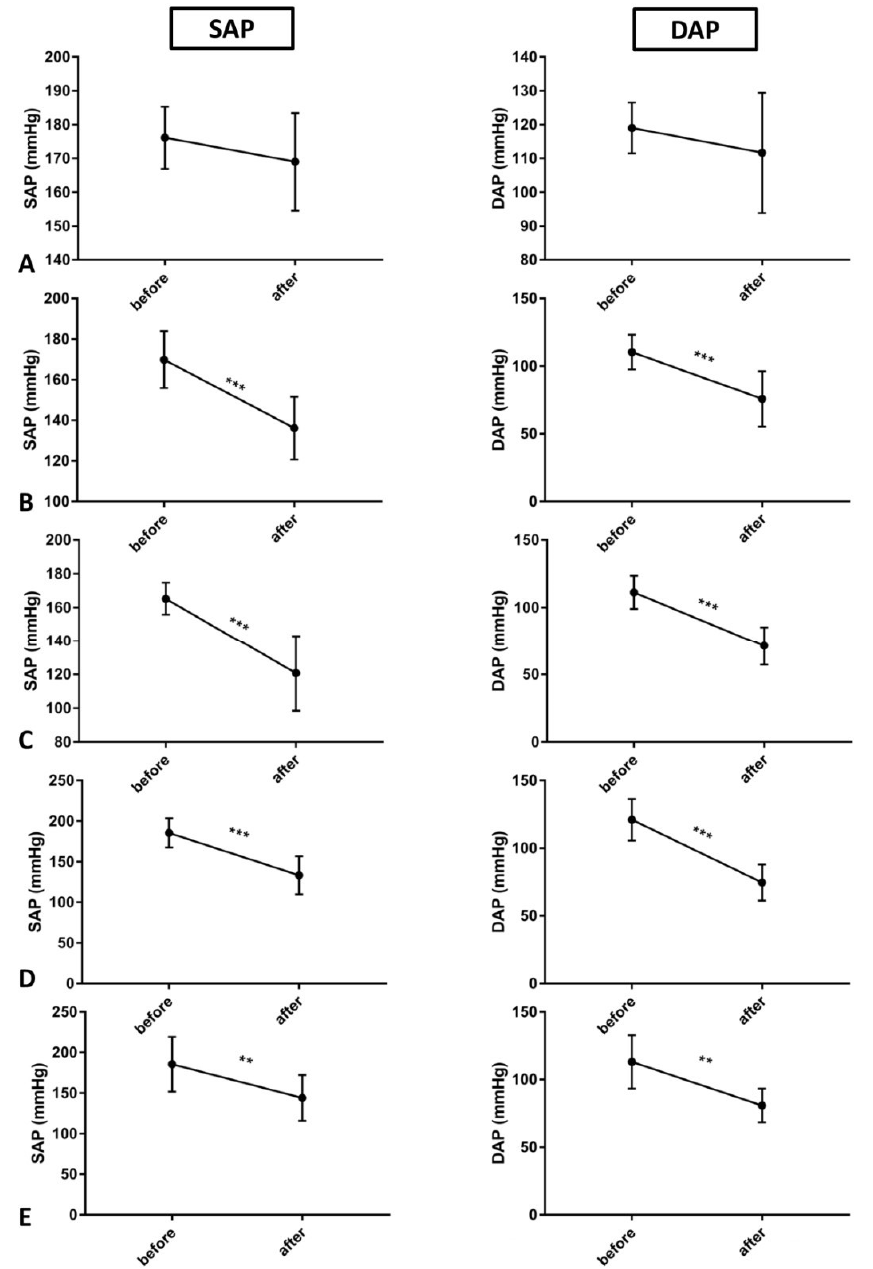
Figure 3. SAP and DAP values before and after surgical procedures in each experimental groups: SHAM ( A ), AKI ( B ), AKI + APO ( C ), AKI + HBO ( D ), AKI + APO + HBO ( E ); SAP—systolic arterial pressure, DAP—diastolic arterial pressure; SHAM—sham-operated rats; AKI—rats with induced postischemic acute kidney injury; AKI + APO—animals with acute kidney injury and apocynin treatment; AKI + HBO—group exposed to HBO preconditioning before acute kidney injury induction; AKI + APO + HBO—animals exposed to HBO preconditioning before and treated with apocynin after acute kidney injury induction. Student’s t-test for dependent samples (before vs. after in each group); ** p < 0.01, *** p <